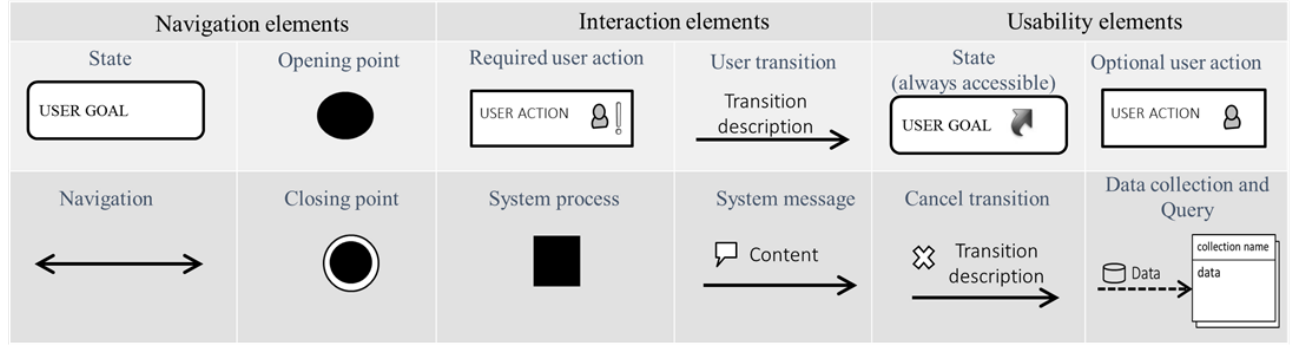
Fig 1. USINN model elements to represent interaction, navigation, and